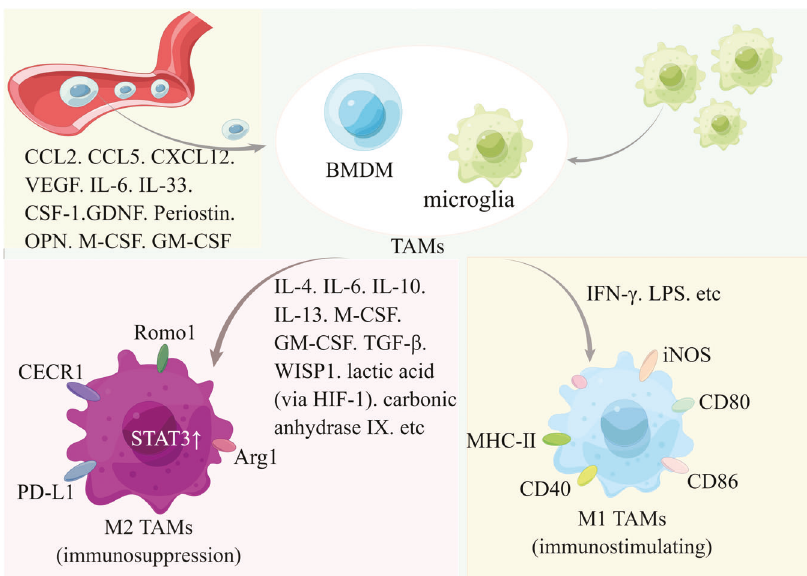
Fig. 2 Recruitment and polarization of TAMs. TAMs consist of residual microglia and bone marrow-derived macrophages (BMDMs). Various molecules are associated with the recruitment and polarization of TAMs. Under different stimuli, macrophages show distinct phenotypes, which can be roughly divided into immunosuppressive M2 phenotype (There ’ s signi fi cant upregulation of STAT3, PD-L1, Arg-1, CECR1, Romo1, etc.) and immune-stimulating M1 phenotype. (By